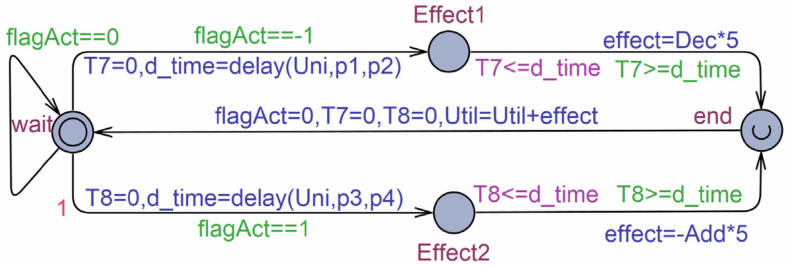
Figure 10. The user customized application logic model for SUIS.